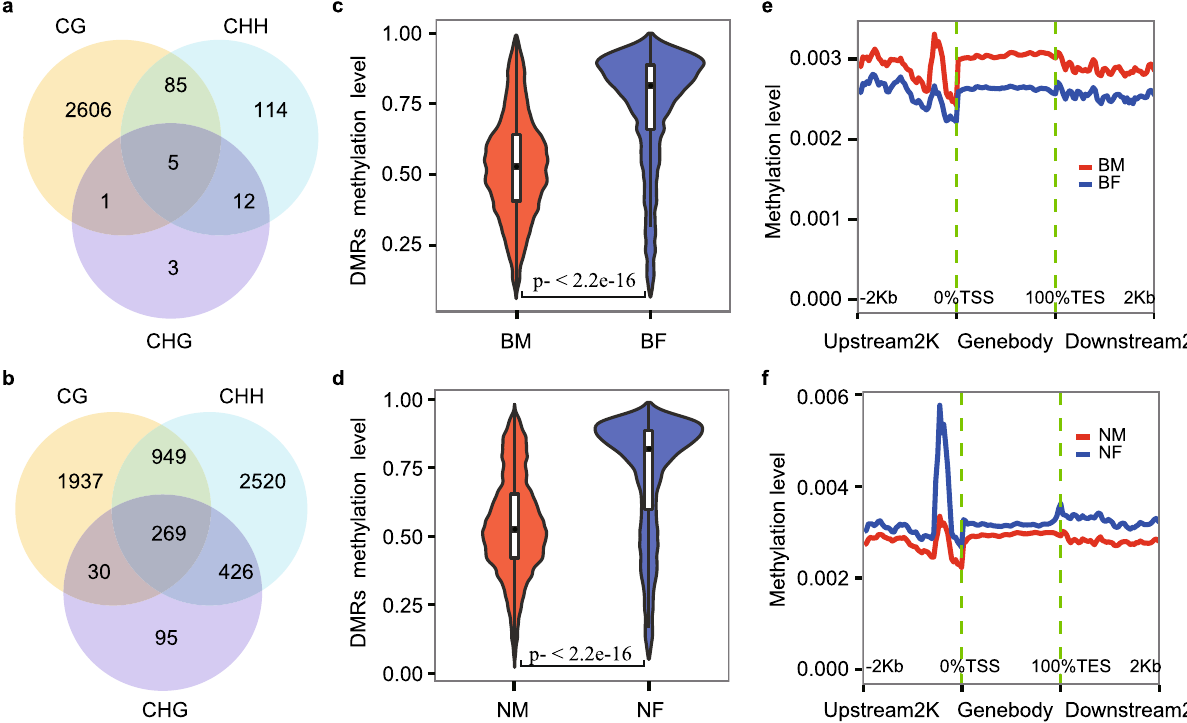
Figure 5. Effects of WEA on methylation difference between adipose and muscle. ( a ) Venn diagram of CG, CHG and CHH DMR genes in muscle. ( b ) Venn diagram of CG, CHG and CHH DMR genes in adipose. ( c ) Comparisons of CG DMRs methylation levels for normal muscle (BM) and adipose (BF) ( p value < 2.2e−16). ( d ) CG DMRs methylation levels for muscle (NM) and adipose (NF) induced by WEA ( p value < 2.2e−16). ( e ) Comparison of CHG and CHH methylation levels against upstream 2 K, gene body and downstream 2 K for normal muscle and adipose. ( f ) Comparison of CHG and CHH methylation level against upstream 2 K, gene body and downstream 2 K for muscle and adipose induced by